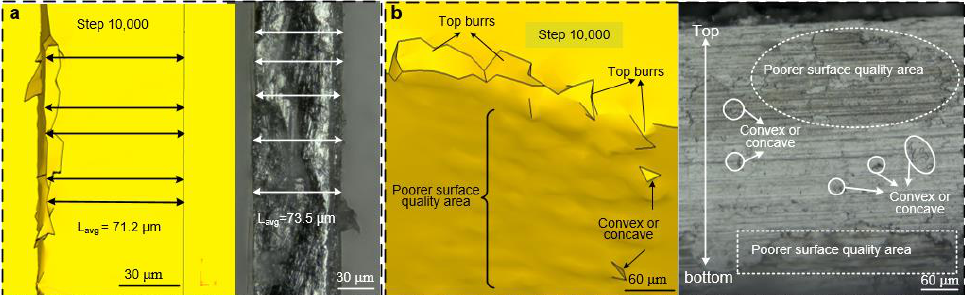
Figure 9. Comparison of milled thin-walled structures between simulation and experiments: ( a ) thicknesses and ( b ) surface quality.